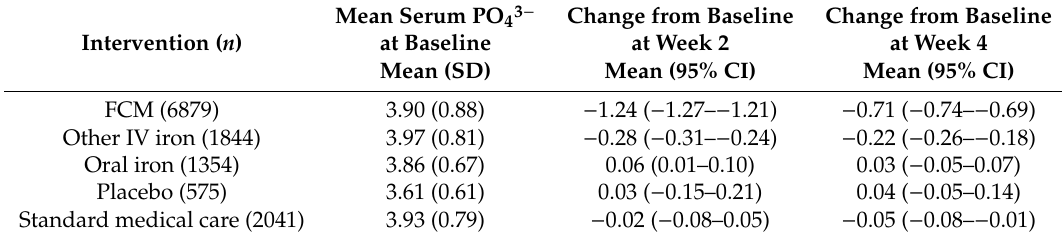
Figure 1. Change from baseline in mean serum PO 43 − over time in patients treated with ferric carboxymaltose. Patients were included from FCM studies ranging from 1 to 52 weeks in duration. As per individual study protocols, some patients received more than one FCM dose, occurring between Week 8 and Week 48. Subject numbers are indicated for each time point. Bars denote standard deviation of the mean. PO 43 − reduction was most pronounced at 2 weeks and gradually faded over the following weeks towards baseline values. FCM, ferric carboxymaltose; PO 43 − , phosphate. Table 1. Variation in mean serum PO 43 − by study intervention with